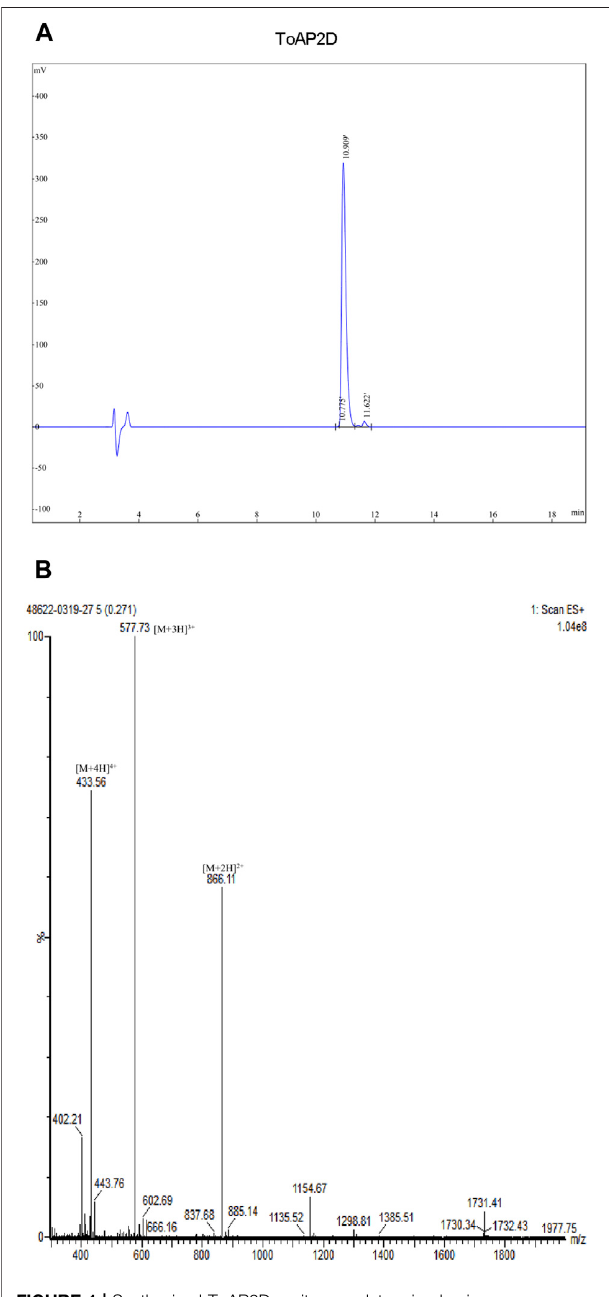
TABLE 3 | Antibacterial diameter of antimicrobial peptides in vitro .